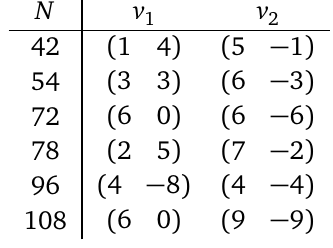
} where u = ( 1,0 ) and u , u 1 2 1